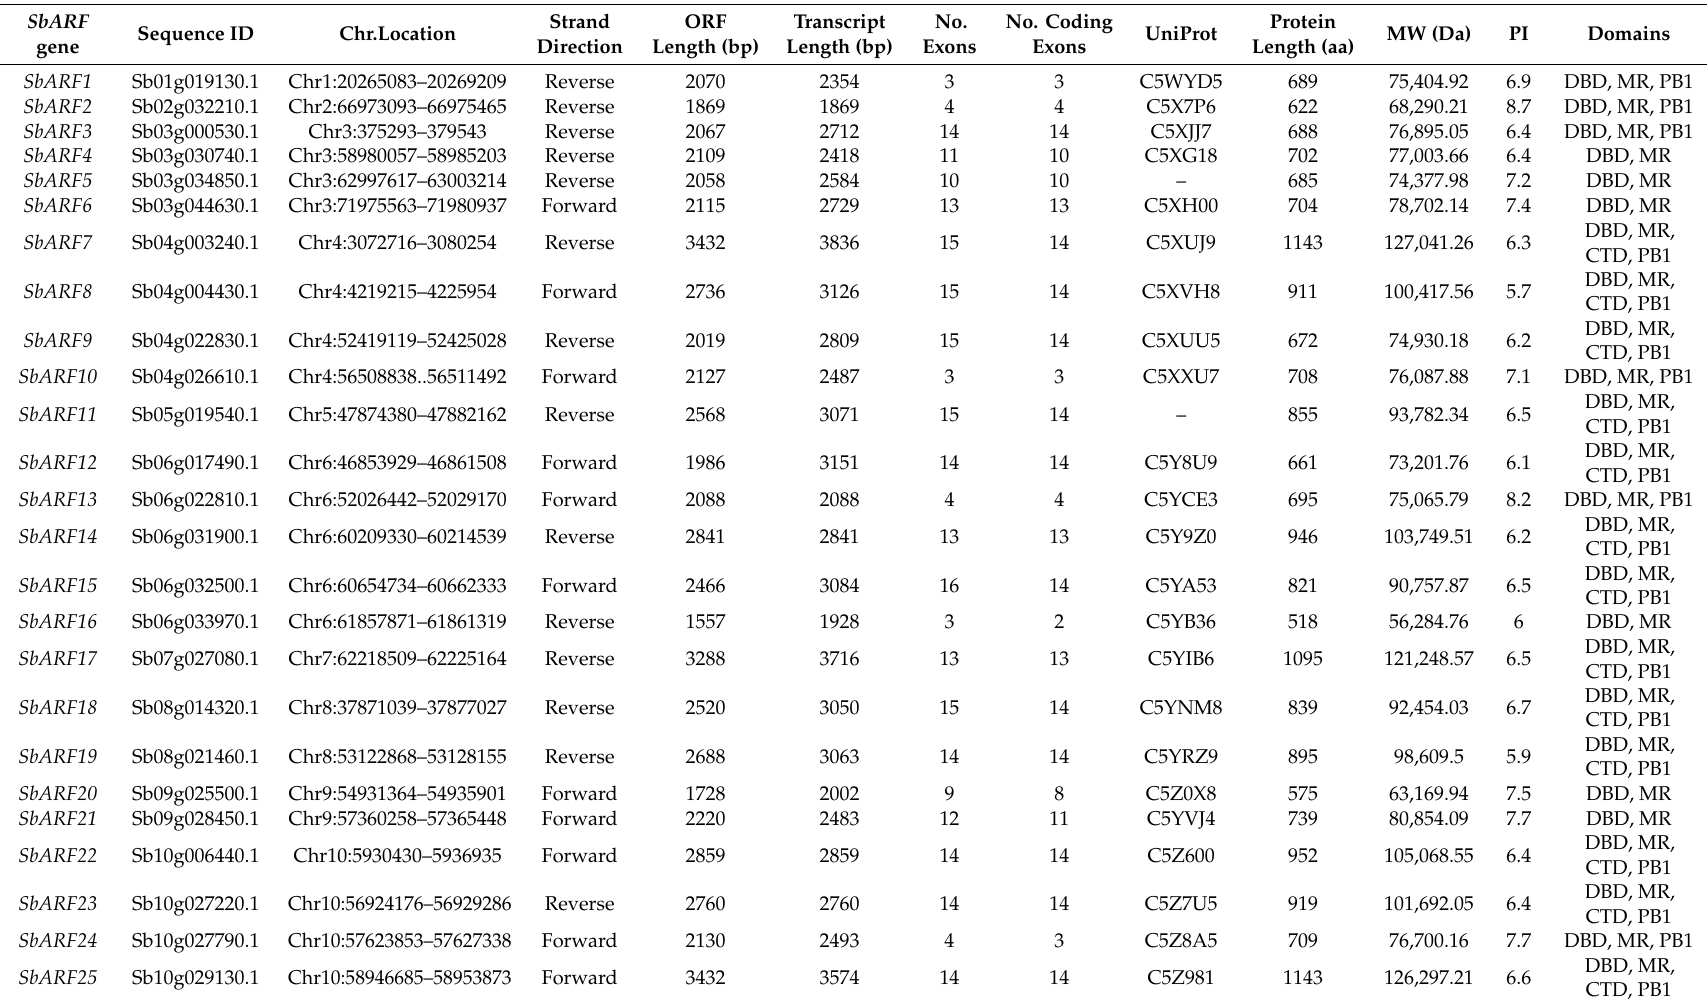
Table 1. SbARF gene family